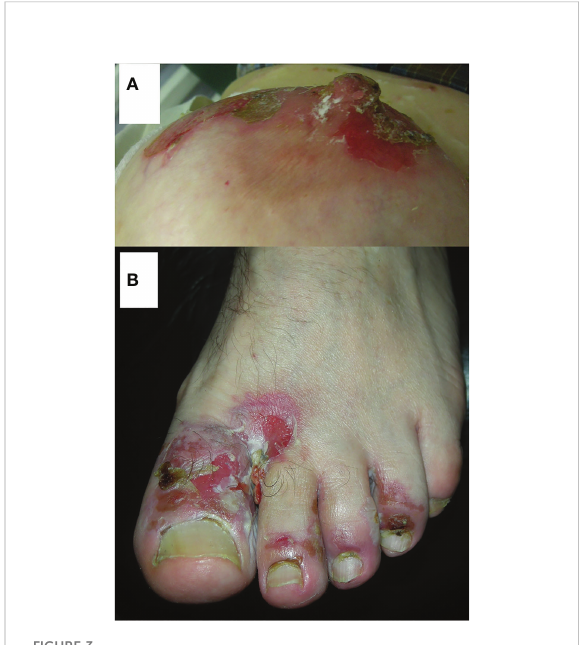
FIGURE 3 Representative PV patients having pemphigus lesions in less obvious locations adjacent to natural body ori fi ces. A middle-aged female with cutaneous variety of PV having pemphigus lesions around the nipple of the breast (A) . Reprinted/adapted with permission, Dmochowski M. P ę cherzyca zwyk ł a „ lubi ” okolice